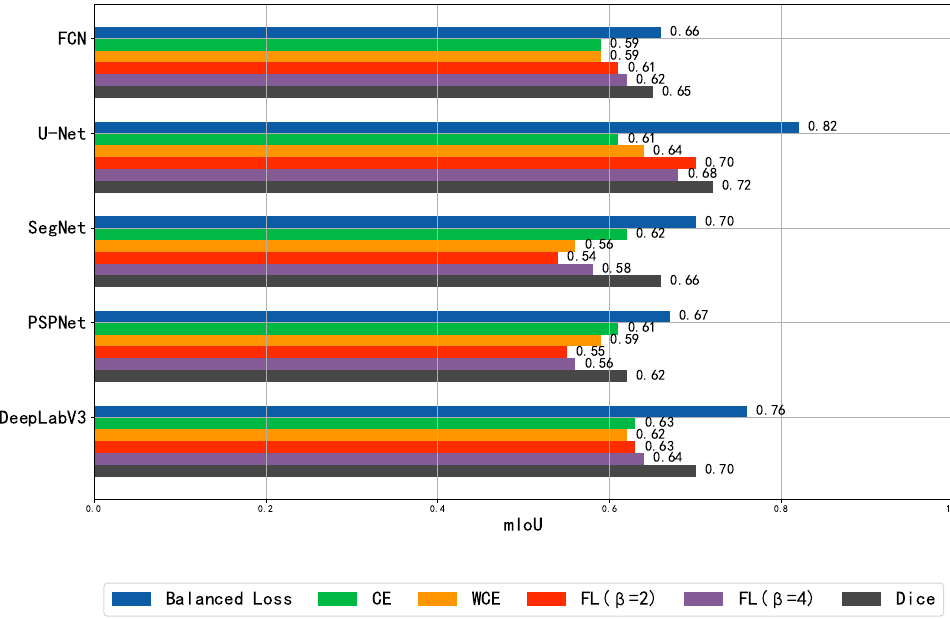
Figure 11. Mean IoU comparison of the balanced loss function and other loss functions on various networks trained on aluminum alloy surface defect